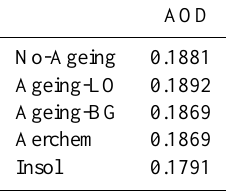
Table 3. Global mean AOD for the five